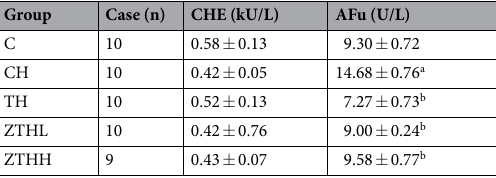
Table 4. Effects of zinc and selenium tea on the serum levels of CHE and AFU in rats (mean and SEM). a Vs C-group, p < 0.01; b vs CH-group, p <